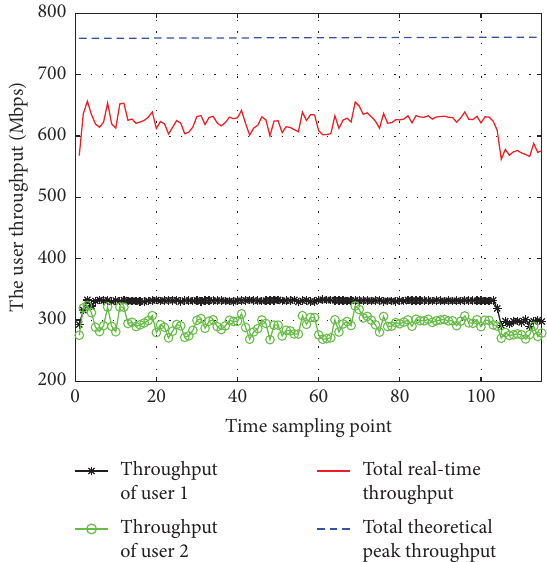
Figure 6: UL rate sampling and probability distribution of single users. Figure 7: UL rate sampling of two users.